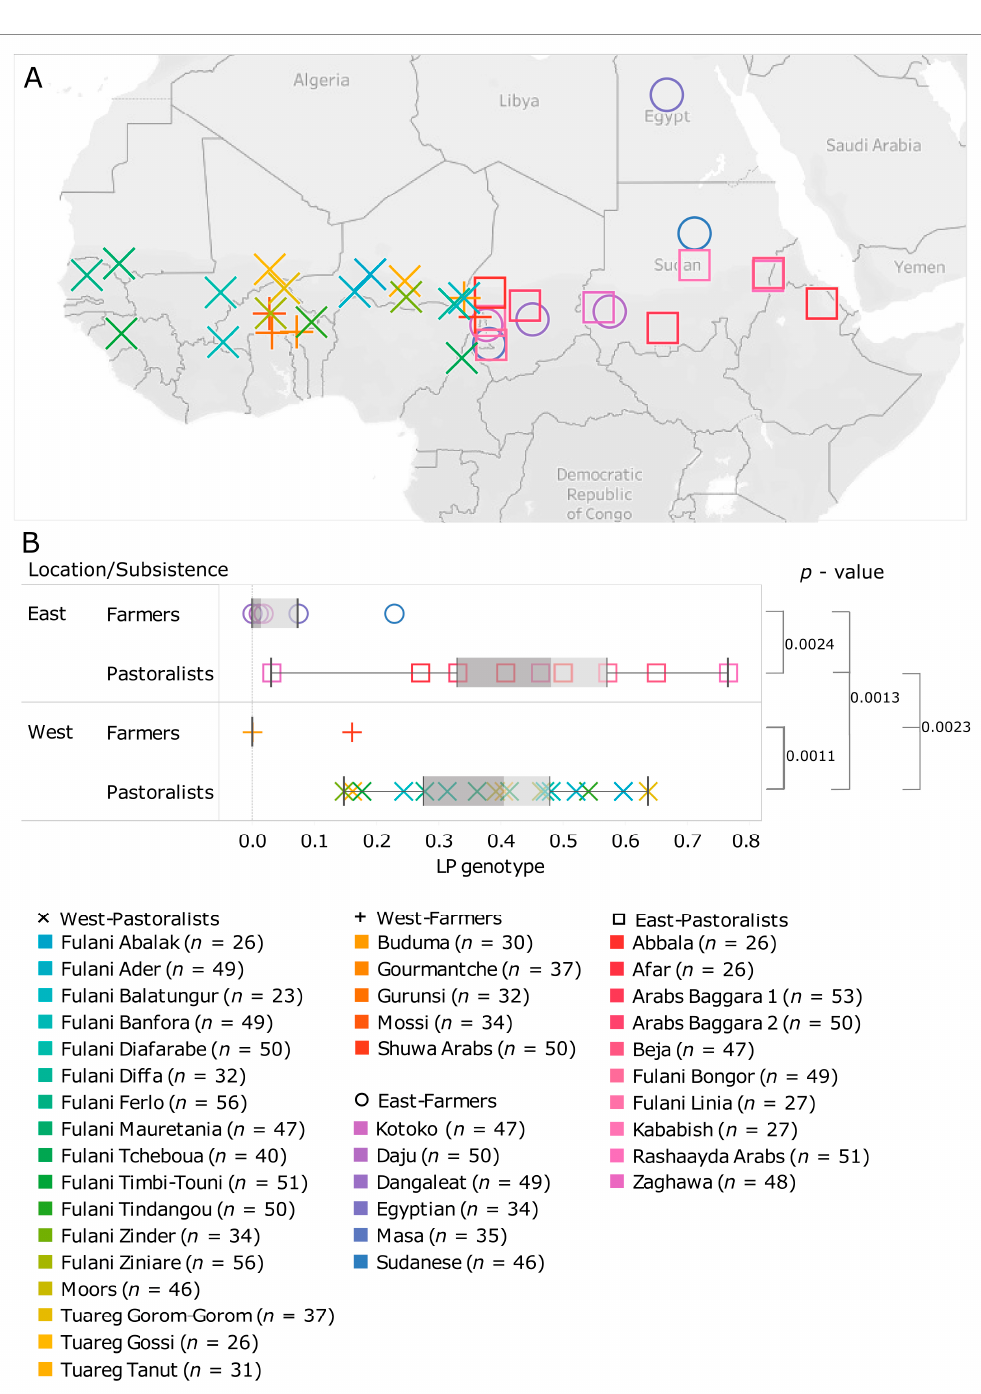
Figure 3. Lactase persistence (LP) genotype in the farmers and pastoralists from the Sahel belt. ( A ) Geographical locations of 38 pastoral and farmer populations analysed for LP mutations in previous studies [37–39]. ( B ) Box plot graphs of the analysed populations divided by the subsistence strategy (pastoralists and farmers) and by location with respect to Lake Chad (east and west). LP genotype is the sum of frequencies of the five LP variants (–13,910*T, –13,915*G, –14,010*C, –14,009*G, and –13,007*G) observed in each group. On the right, we report statistical significances ( p -values) given by the Kruskal–Wallis test (test considered significant when p ≤